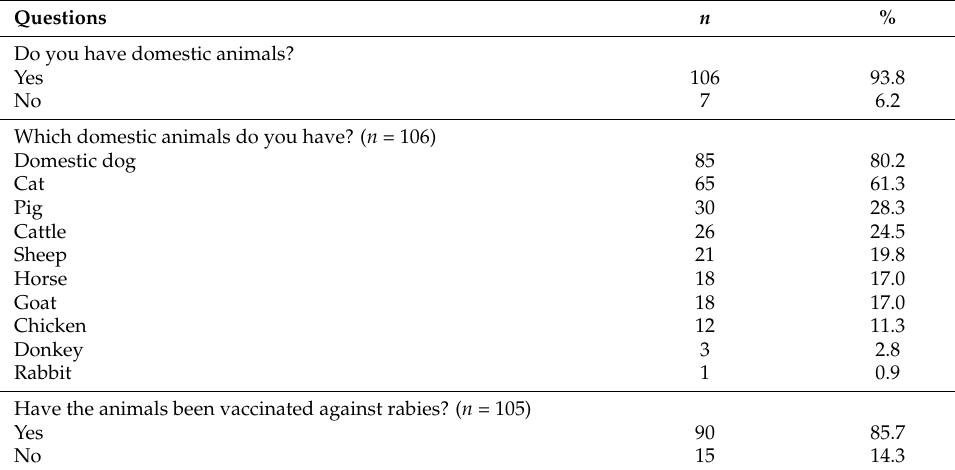
Table 4. Presence of domestic animals in the households and vaccination status, Cear á , Brazil, 2021 ( n =